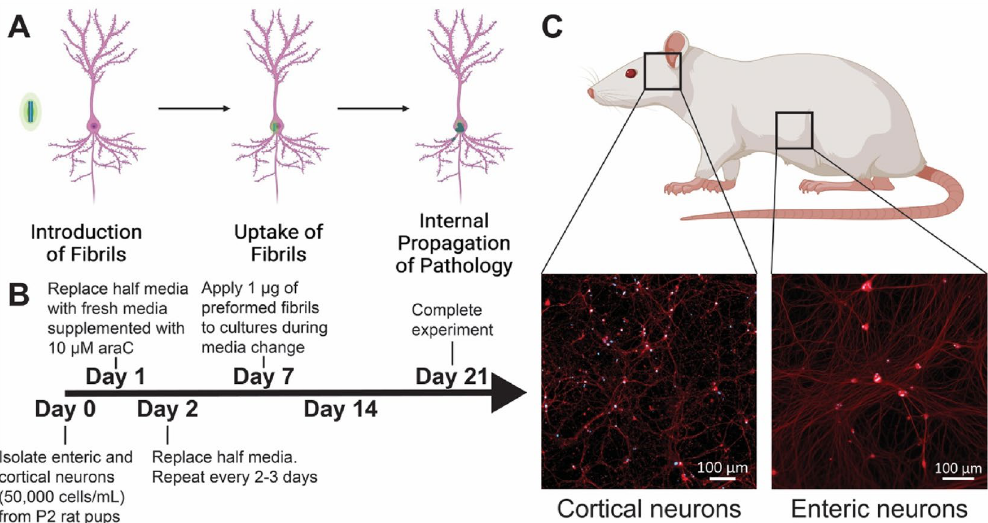
Figure 1. Schematic representation of the experimental design. ( A ) Illustration of the theorized preformed fibrils (PFF) toxic progression from the introduction of PFFs to uptake into neurons and development of further aggregation from endogenous α-synuclein (a-Syn). ( B ) Timeline of experimental design. Cultures were fed every 2–3 days throughout the experimental timeline. ( C ) Representative images of neuron populations (cortical and enteric) isolated for experimental procedures illustrated linking to anatomical location. Images are merged (Red = beta-3 tubulin, Blue = DAPI). Scale = 100 µm. Figure created with